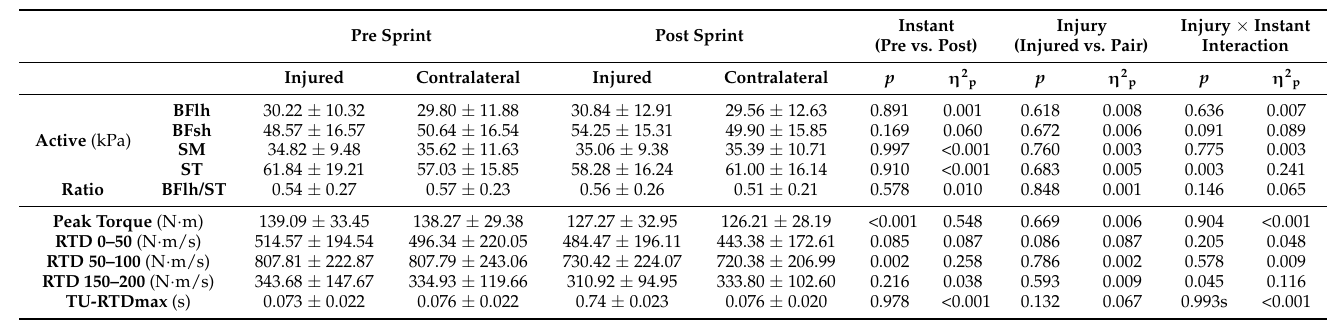
Table 3. Acute effects of a sprint protocol in limbs with hamstring injury history (n = 34) vs. healthy contralateral limbs without injury history (n = 34) on active shear modulus and neuromuscular parameters values.